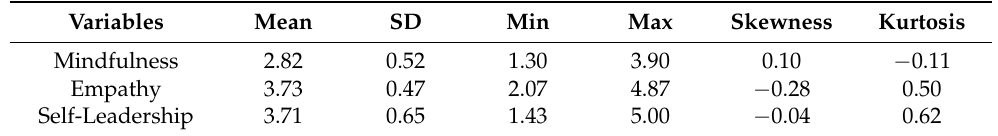
Table 1. Mean, standard deviation, skewness, and kurtosis values of the variables.